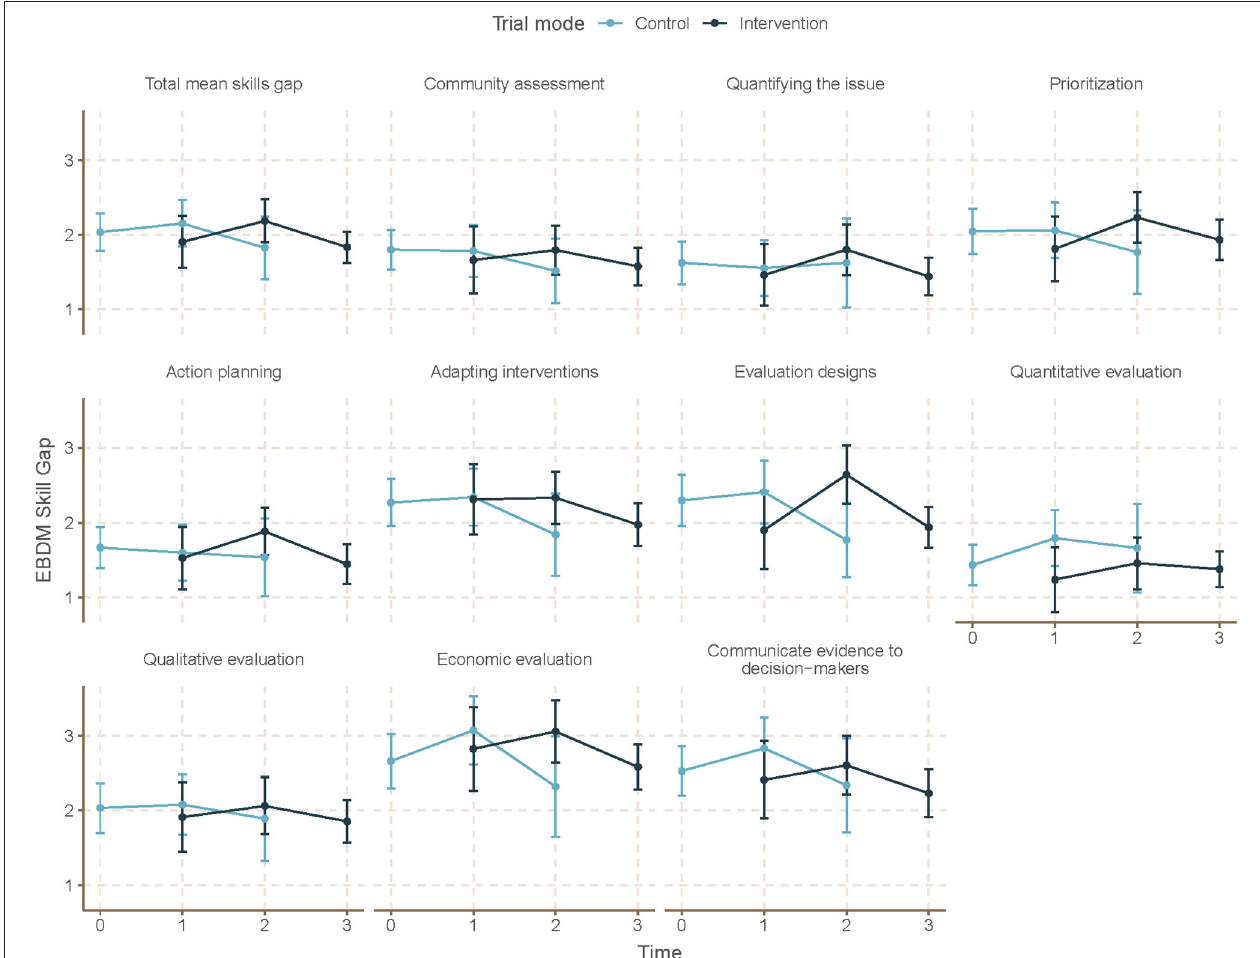
FIGURE 3 | Mean EBDM skill gaps by time and trial mode. At each time point, mean and 95% confidence intervals for skill gaps in evidence-based decision making (EBDM) are displayed for individuals during control and intervention phases. EBDM skill gaps come from importance and availability of 10 skills measured on an 11-point ordered scale. For each skill, a skill gap was calculated by subtracting the availability rating from the importance rating. Time 0 represents baseline where all units (local health departments) were in control period. Time 3 is the final data collection point and all individuals are in intervention period. Total mean skill gap score was created as an average of the 10 individual competency